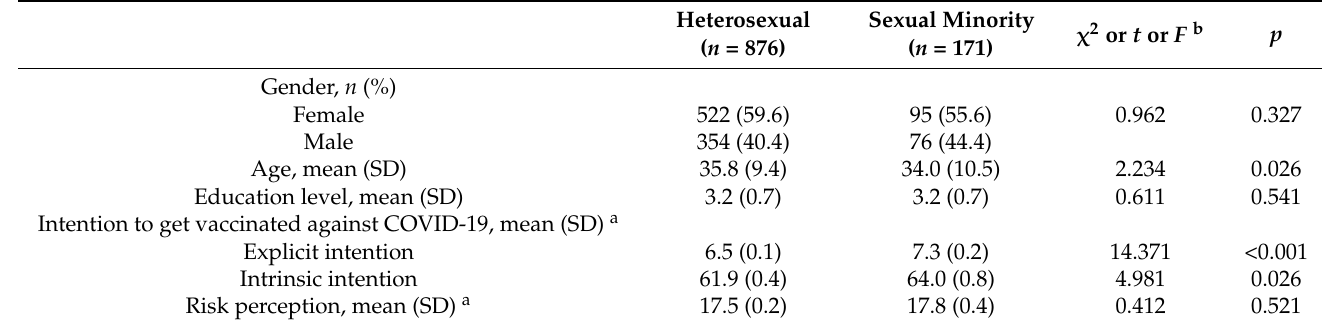
Table 2. Comparisons of heterosexual and sexual minority participants’ demographic characteristics, explicit and intrinsic intention to receive COVID-19 vaccination, and risk perception.